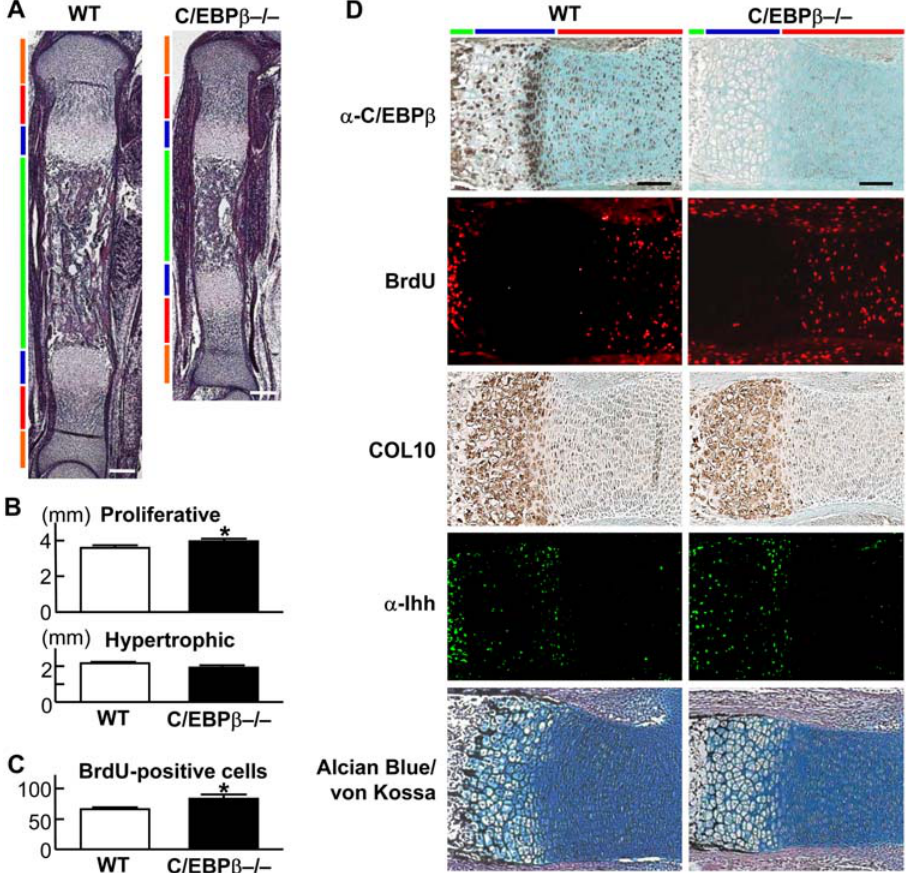
Figure 2. Hypertrophic differentiation of chondrocytes is delayed in the C/EBP b 2 / 2 limb cartilage. (A) HE staining of whole tibias of wild-type (WT) and C/EBP b 2 / 2 littermate embryos (E16.5). Orange, red, blue, and green bars indicate layers of resting zone, proliferative zone, hypertrophic zone, and bone area, respectively. Scale bars, 200 m m. (B) Length of proliferative and hypertrophic zones of the two genotypes. (C) Number of BrdU-positive cells in the proximal tibia of the two genotypes. Data are expressed as means (bars) 6 SEM (error bars) of 5 mice per genotype. *P , 0.05 vs. WT. (D) Immunostaining with an antibody to C/EBP b ( a -C/EBP b ), BrdU labeling, in situ hybridization of type X collagen (COL10), immunostaining with an antibody to Ihh ( a -Ihh), and Alcian blue/von Kossa double stainings of the tibial cartilage in two genotypes. Color bars indicate layers as above. Scale bars, 100 m m.